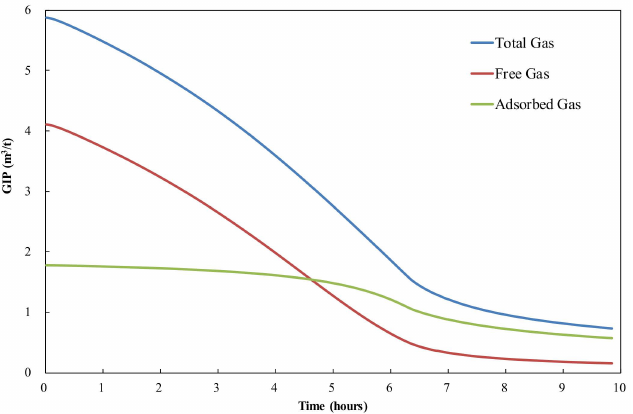
Figure 8. The evolution of total gas, free gas, and adsorbed gas from “time zero” to the end of first stage of desorption from our